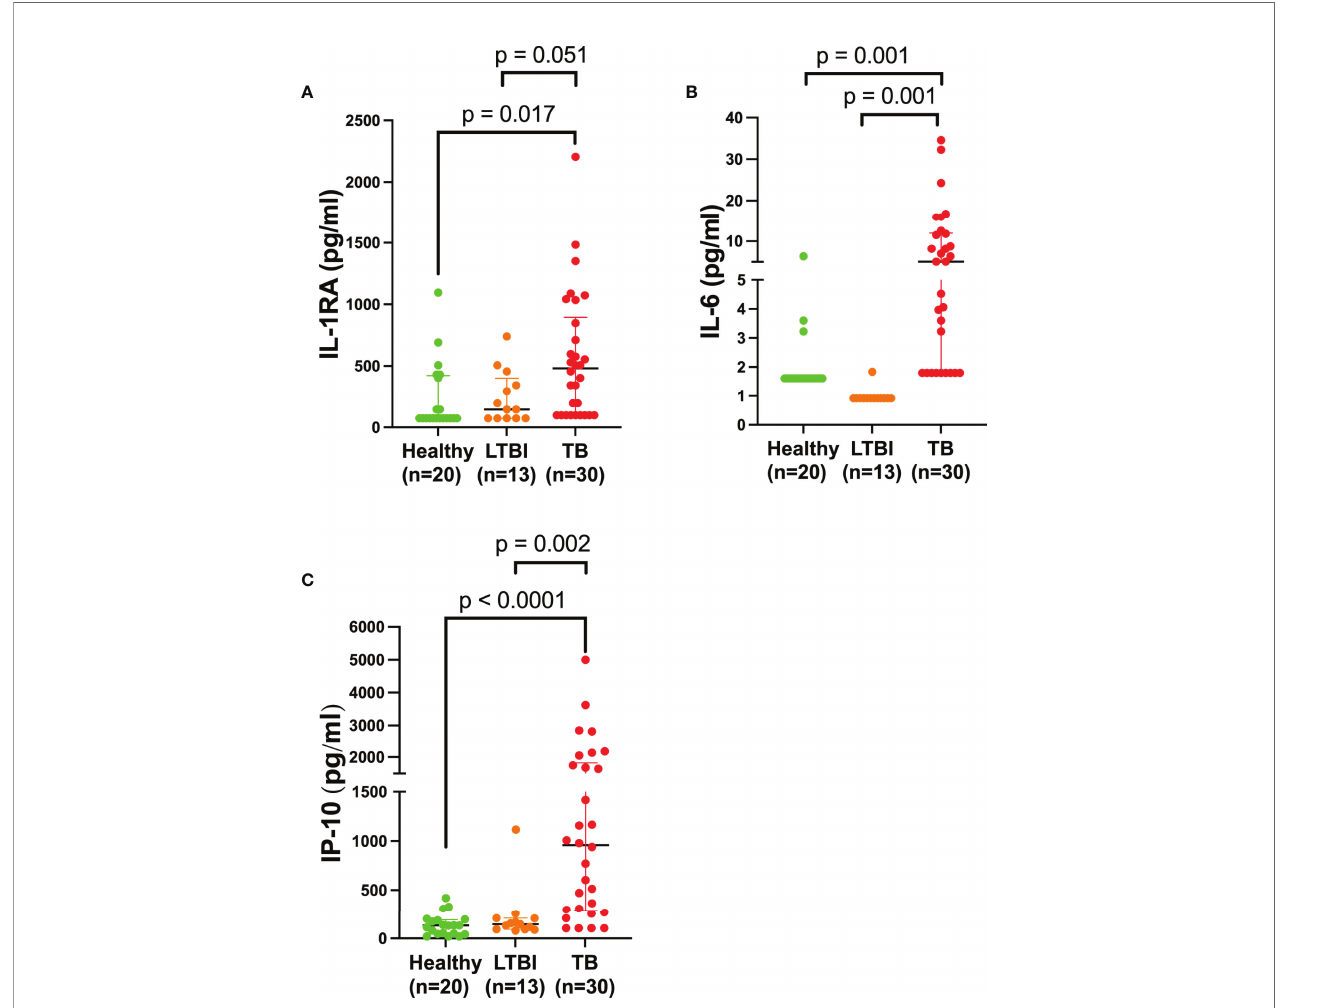
FIGURE 2 | Plasma IL-RA, IL-6, and IP-10 are elevated in TB patients. Quanti fi cation of various cytokines in the plasma of healthy (n=20) individuals compared to LTBI (n=13) and TB (n=30) patients. Each dot represents a participant sample. (A) IL-1RA, (B) IL-6, and (C) IP-10 were quanti fi ed and measured in pg/ml. Signi fi cant differences were identi fi ed as those values that were less than p <0.05. Data was analyzed using the one-way ANOVA and followed by a multiple comparisons test using Tukey ’ s test. Tukey ’ s p -values have been reported in the above fi gure and illustrate the differences observed between